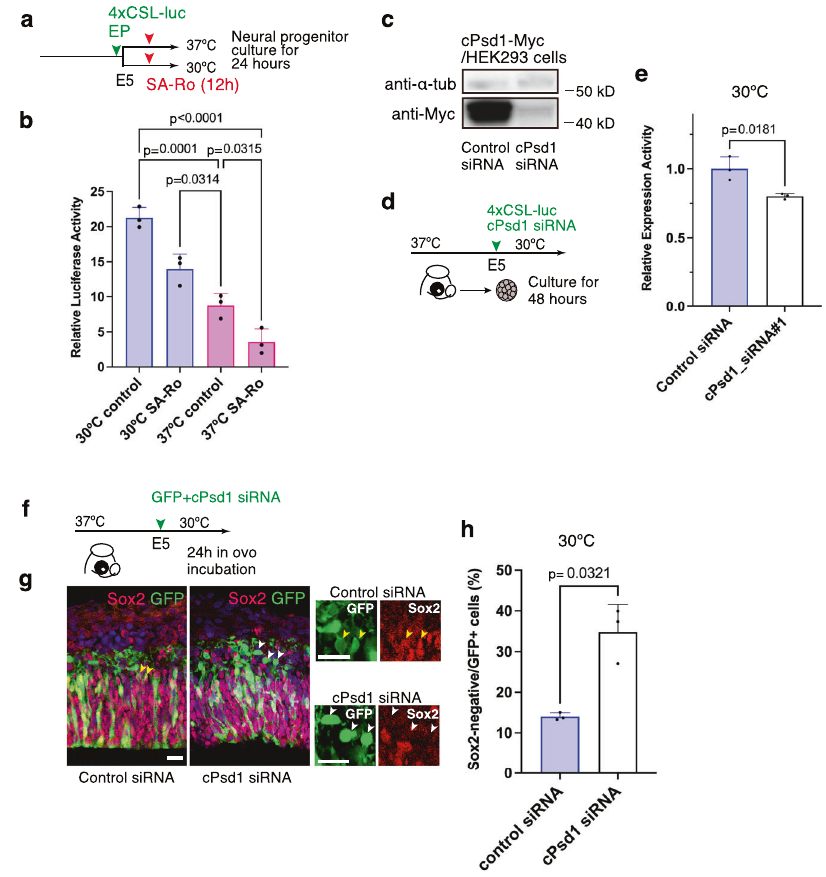
Fig. 4 PE mediates hypothermia-dependent increases in Notch activity. a Trapping of cell surface PE in cultured chick neural progenitors by treatment with SA-Ro for 12 h. b Notch reporter activity in chick neural progenitors treated with SA-Ro at different temperatures (mean + SD, n = 3 biologically independent samples in each group). c Western blotting of Myc-tagged chick Psd1 in HEK293T cells transfected with siRNAs. d Introduction of the Notch reporter vector and siRNA targeting Psd1 in isolated chick neural progenitors. e Notch reporter activity in chick neural progenitors transfected with control or Psd1 siRNAs (mean + SD, n = 3 biologically independent samples in each group). f Schematic illustration of cPsd1 siRNA introduction in the developing chick pallium. g Distributions of GFP-positive cells in control and cPsd1 siRNA overexpressing chick pallium incubated at 30 °C. h The proportion of Sox2- negative and GFP-positive cells in control and cPsd1 siRNA overexpressing chick pallium at 30 °C (means + SD, n = 3 biologically independent samples in each group). Ordinary one-way ANOVA for b ( p -values were adjusted by Tukey test for multiple comparisons), two-sided, unpaired t -test for e , h . P -values are indicated in each graph. Scale bars: 25 µ